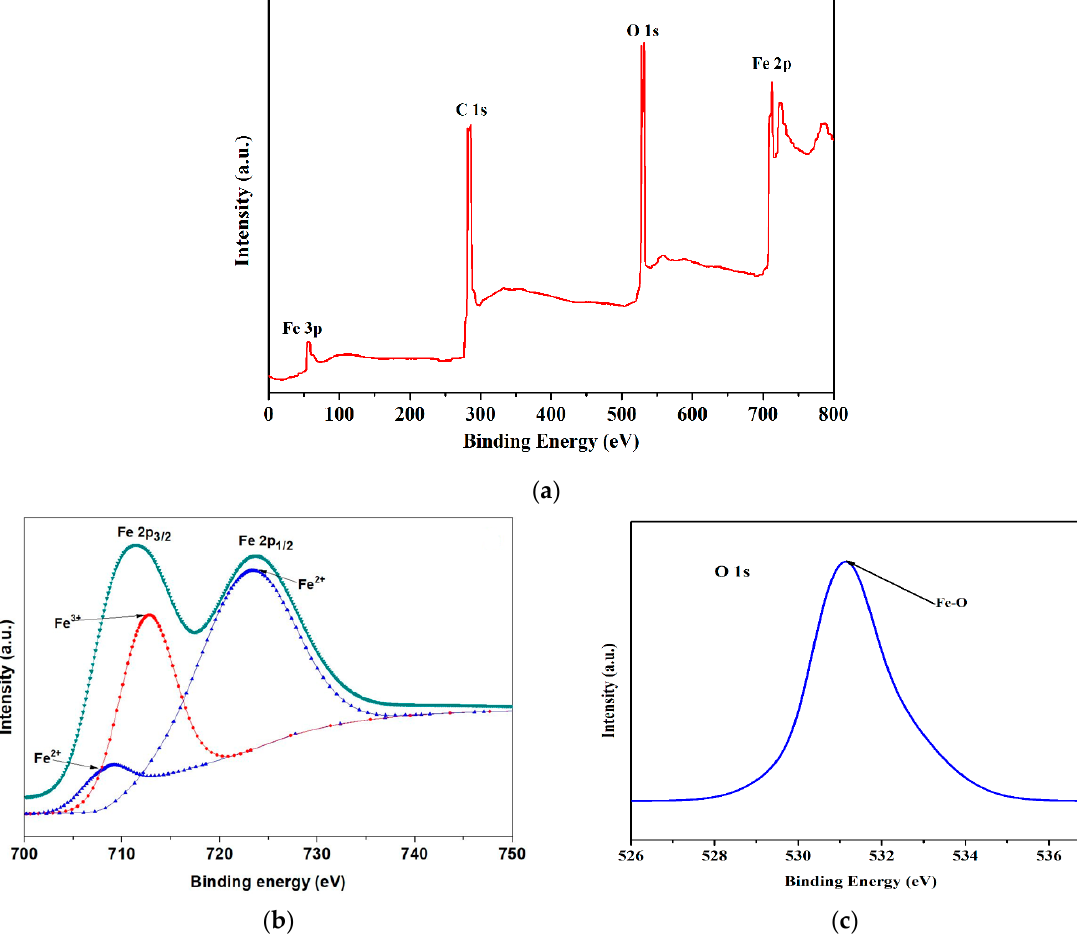
Figure 6. ( a ) Full XPS spectrum, ( b ) High-resolution XPS spectrum of Fe 2p and ( c ) High-resolution XPS spectrum of O 1s of MIONPs.